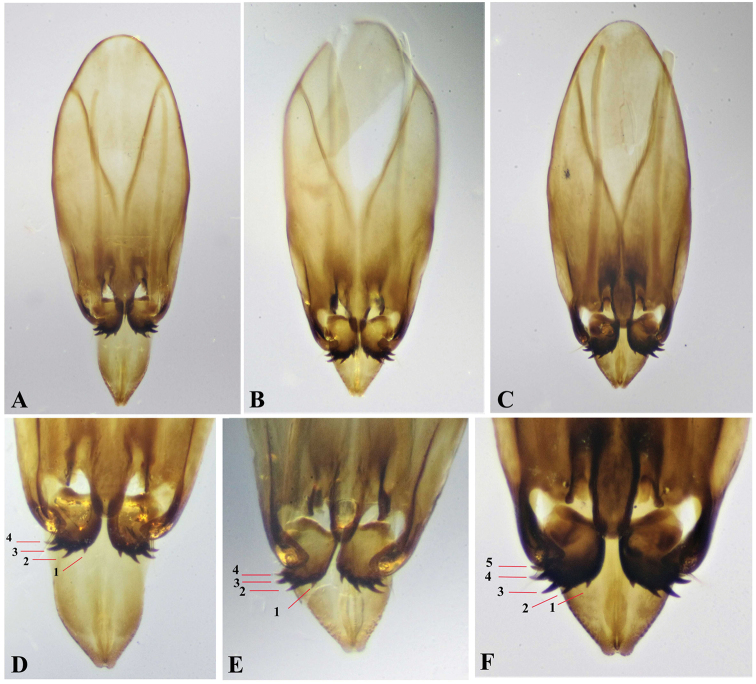
Dorsal aspect and tip of male genitalia, Paratype A, DOodera
omanensis sp. nov. B, EOodera
rapuzzii sp. nov. C, FOodera
similis sp. nov. (numbers 1−5 indicate number of teeth on volsellae).